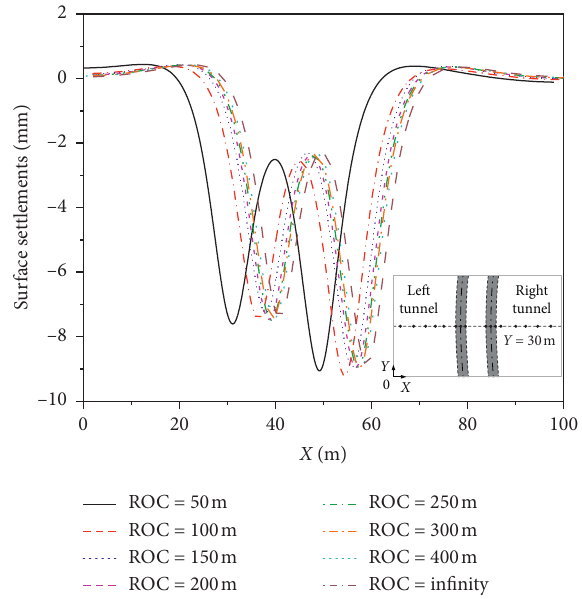
Figure 9: Ground surface settlement troughs along Y � 30m at the final step induced by curved tunnelling at various radii of Figure 11(a), when the radius of curvature of tunnel alignment equals 50 m, the magnitude of the ground set- tlement decreases from about 9.17 mm on the ground surface to about 3.08 mm at the tunnel vault; the ground heaves at the tunnel bottoms are approximately 9.12 mm.